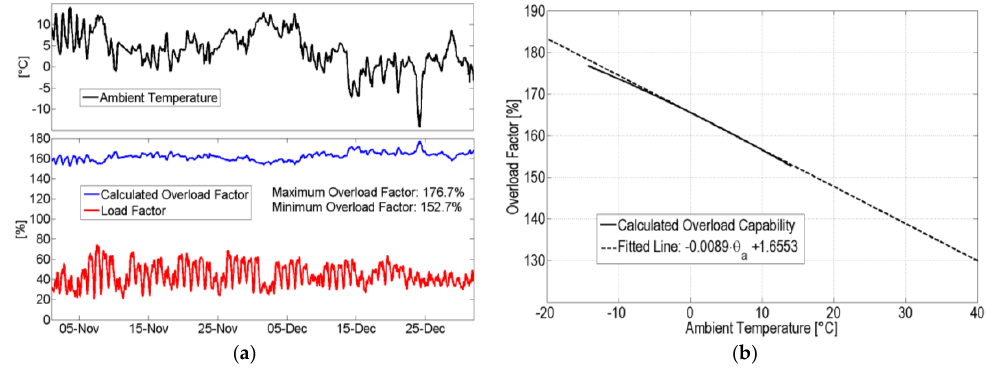
Figure 24. ( a ) Ambient temperature, long-term overload factor and load factor; and ( b ) dependency of overload capability on ambient temperature [56].